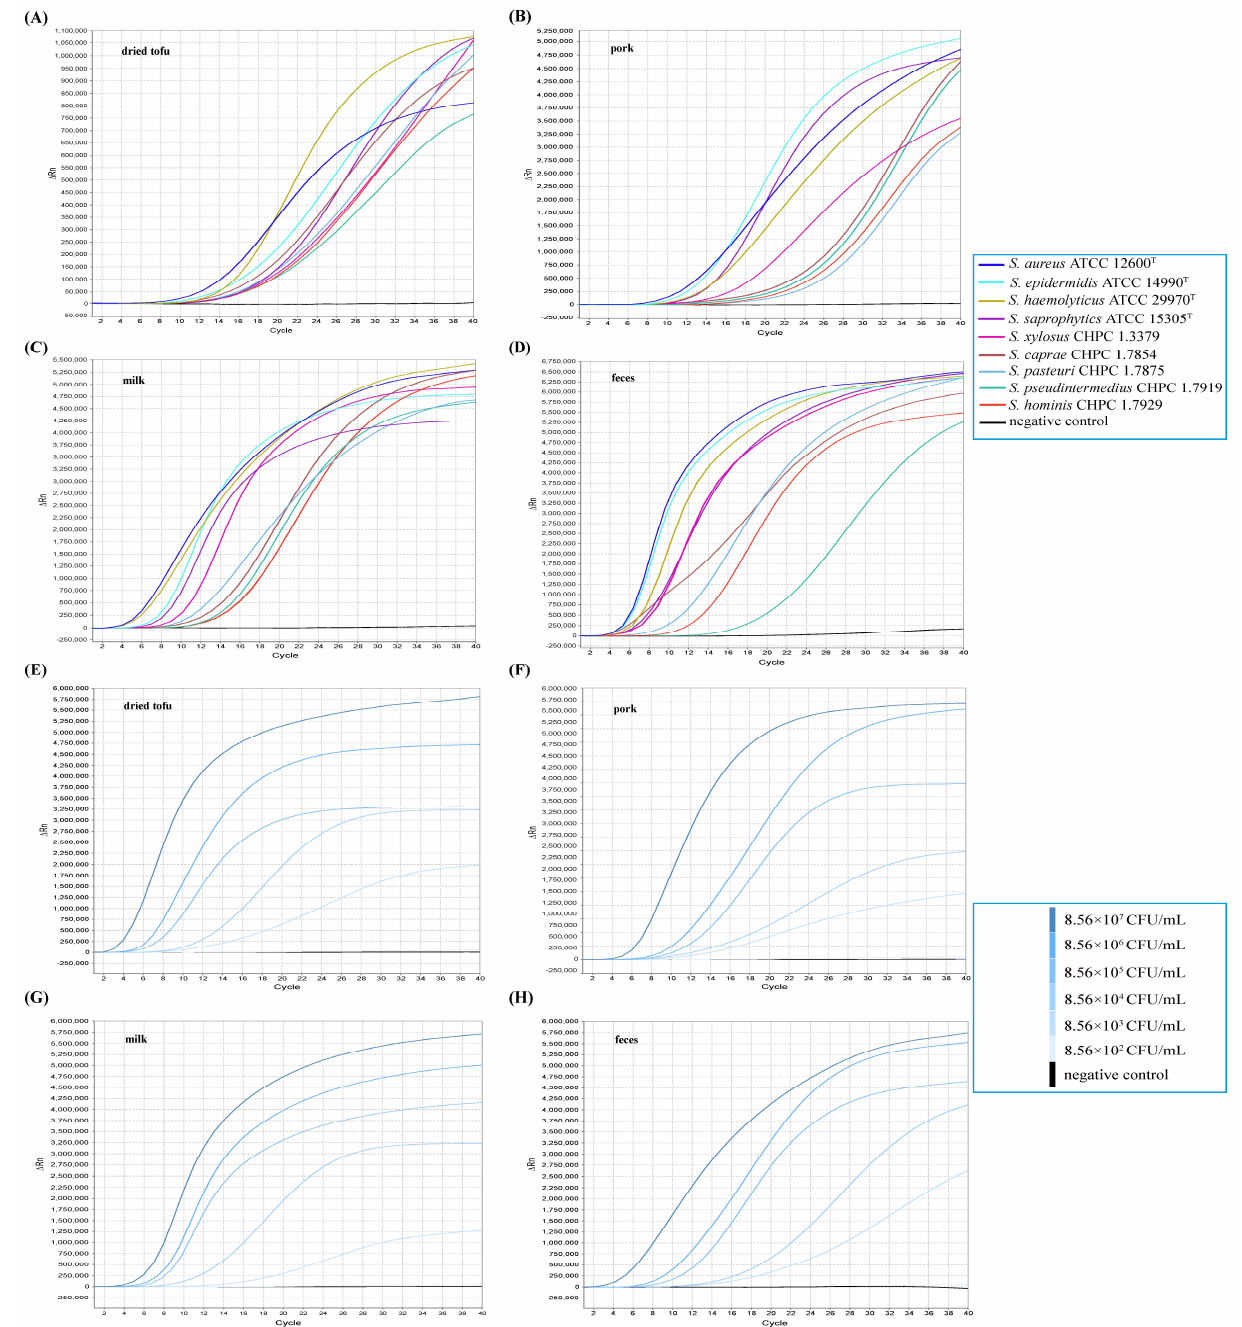
Figure 5. Detection of the Staphylococci strains in simulated samples by MIRA-qPCR. ( A – D ) Detection of nine Staphylococci species strains. ( E – H ) The LoD of S. aureus ATCC 12600 T strain.